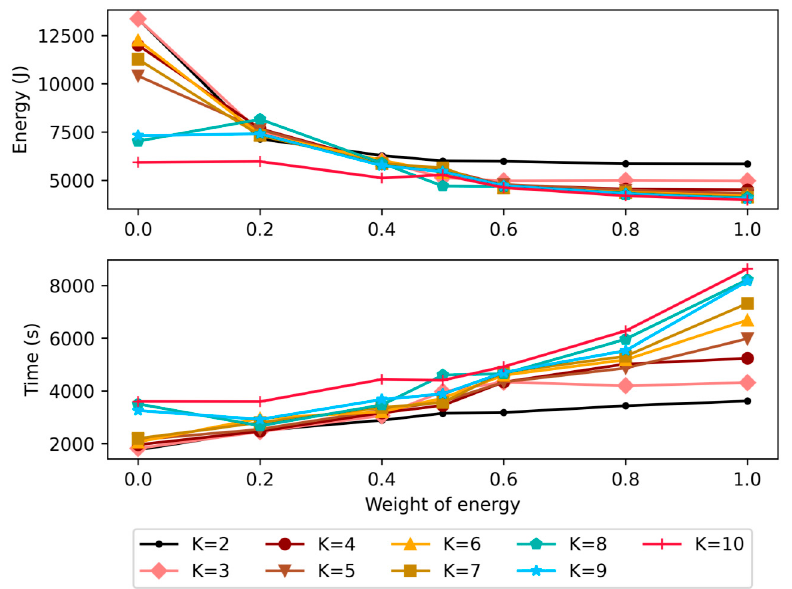
Figure 8. Two-dimensional graph of energy and time variation with different weights (top: energy varying with different weights; bottom: time varying with different weights).